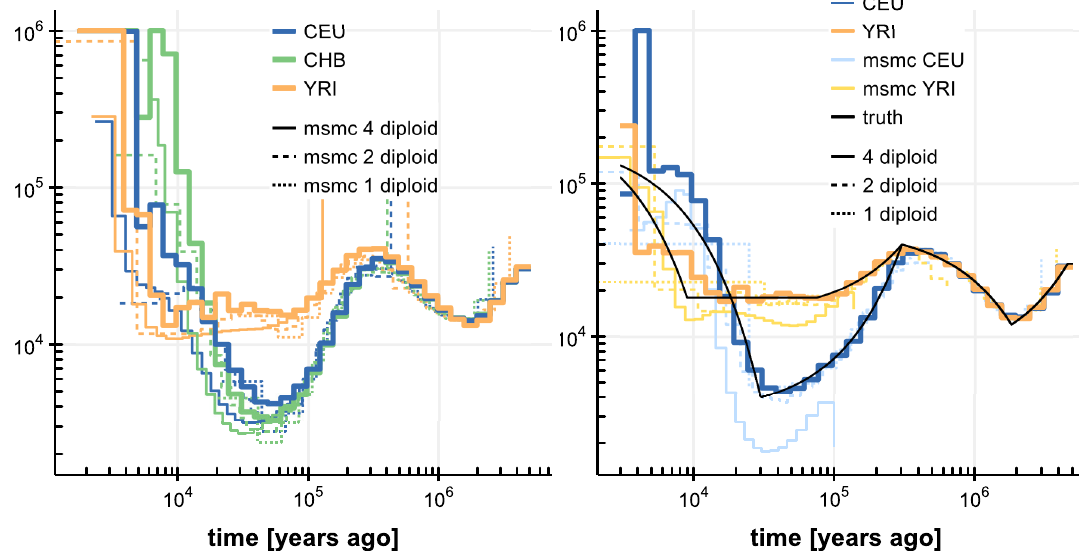
Fig 3. Population size inferences by SMCSMC on four diploid samples. Left, three human populations (CEU, CHB, YRI), together with inferences from msmc using 1, 2 and 4 diploid samples. Right, simulated populations resembling CEU and YRI population histories. All inferences ( SMCSMC , msmc ) were run for 20